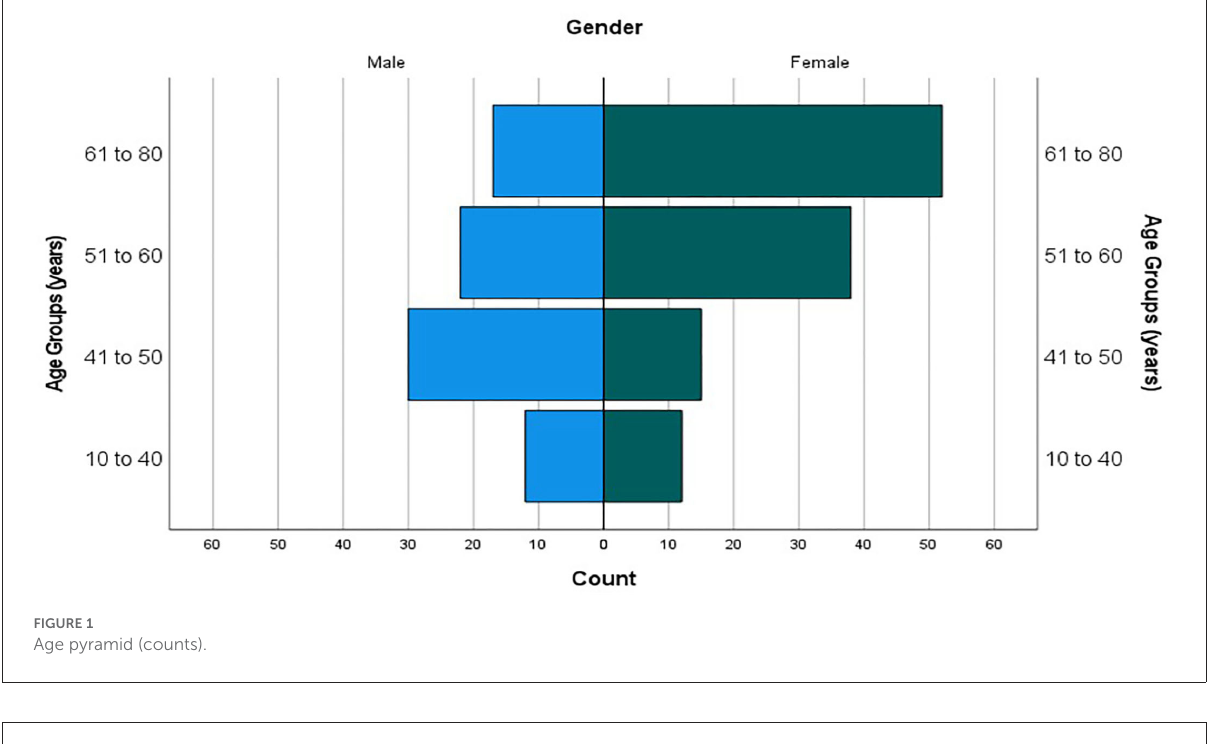
FIGURE1 Age pyramid (counts).